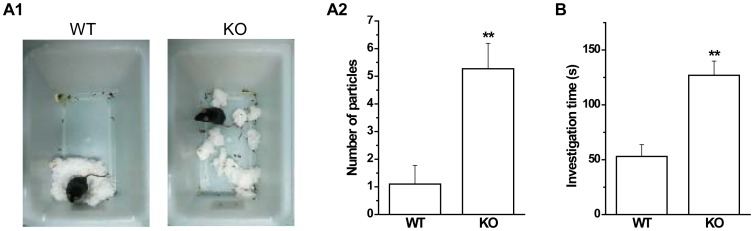
GAT1 KO mice show abnormal social behavior.
A1, Representative pictures of the cages of WT and KO mice. A2, Statistical results showing the number of cotton particles in the cages. n = 9–11 for each genotype, ** p<0.01 vs WT, t-test. B, GAT1 KO mice showed more social investigation time to an unfamiliar juvenile conspecific than that of WT mice. n = 9–10 for each genotype, ** p<0.01 vs WT, t-test.